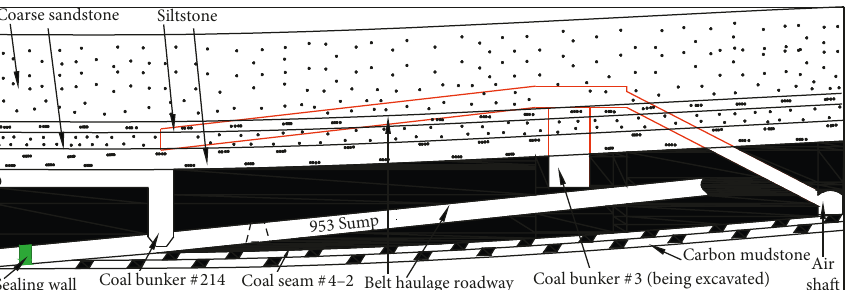
Figure 4: Geological cross section through coal bunkers #214 and #3.